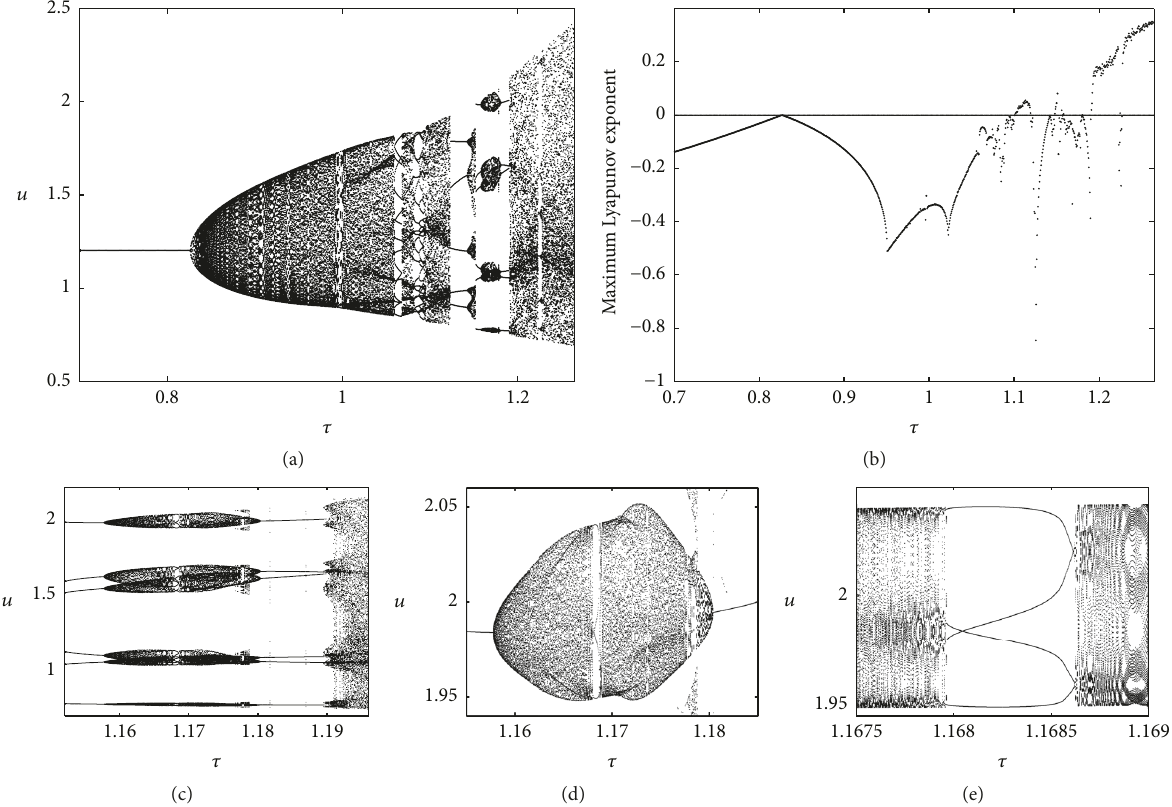
Figure 7: (a) Neimark-Sacker bifurcation diagram with parameter values given as 𝑎 = 2 , 𝑏 = 2 , 𝑐 = 2 , 𝑑 = 1.95 , 𝛼 = 0.1 , and 𝛽 = 0.1 ; (b) maximum Lyapunov exponent corresponding to (a); (c) local amplification of (a) in the range of [1.152, 1.196] ; (d)-(e) amplifications of dynamics on each branch of period-6 orbit in